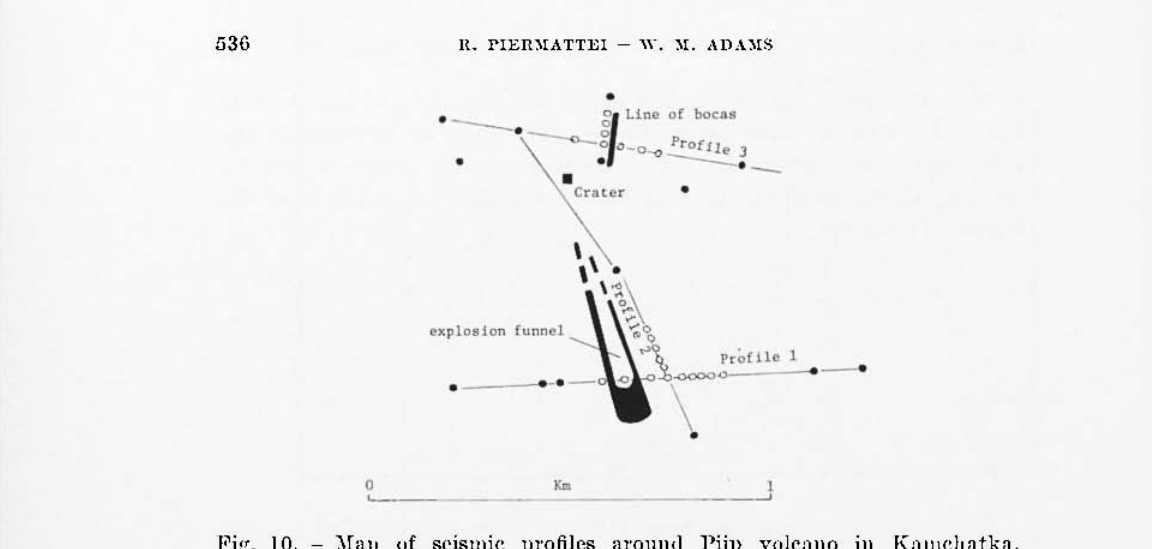
~'-------' Pig. IO. - ~ral) of spismi(' jl1"OfiICS a1"011IHI Piip yolr'ano in Kallleltatka. Solill l'oints il1(lieate tlte sllOtl'oints; hollow rireles, the loralion of the in St.1"1111lcnts; anll flOlil1 lillefl, the jlmfile anangClllcnts [n'll1"awn aH('!" Halesta a!HI Parberov (3)].